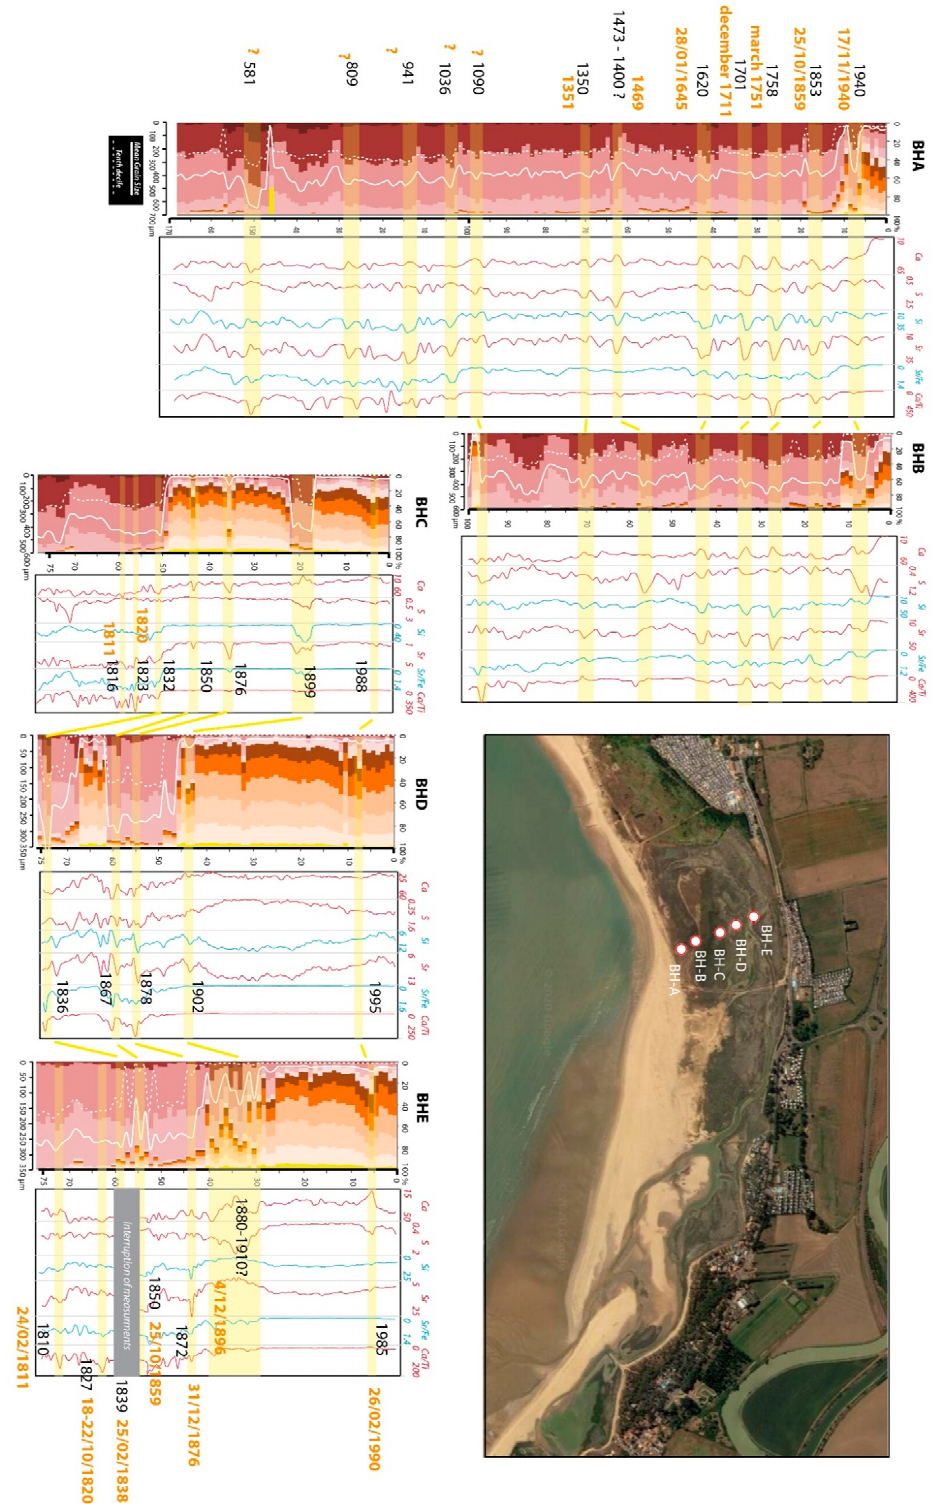
Figure 9. Detection of marine layers linked to historical storms found in archives. The five cores show different storm proxies: grain size data (sands proportions with the red gradient; silts proportions with the orange gradient; clay proportions in yellow; and MGS in the solid line and the tenth decile in chest line) and geochemical results (Ca, S, Sr, Si, Sr/Fe, and Ca/Ti). The marine layers are highlighted in yellow, with their isotopic dating in black. Related past extreme event hypothetical dates extracted from historical sources are written in orange. The aerial photograph was extracted from Google